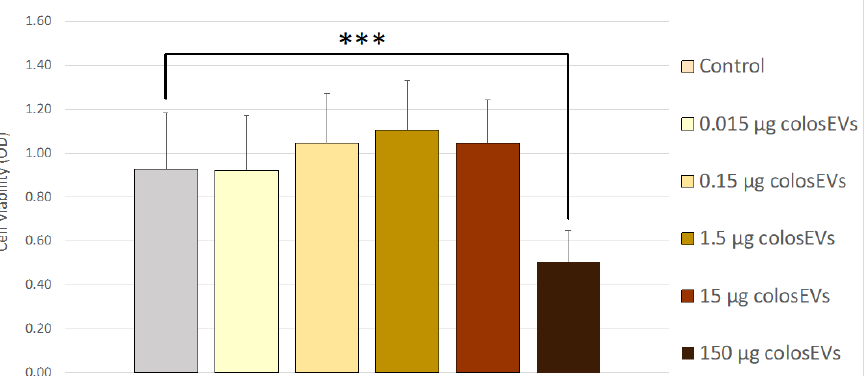
Figure 2. Viability of IPEC-J2 after colosEVs exposure at 48 h. The different concentrations of colosEVs